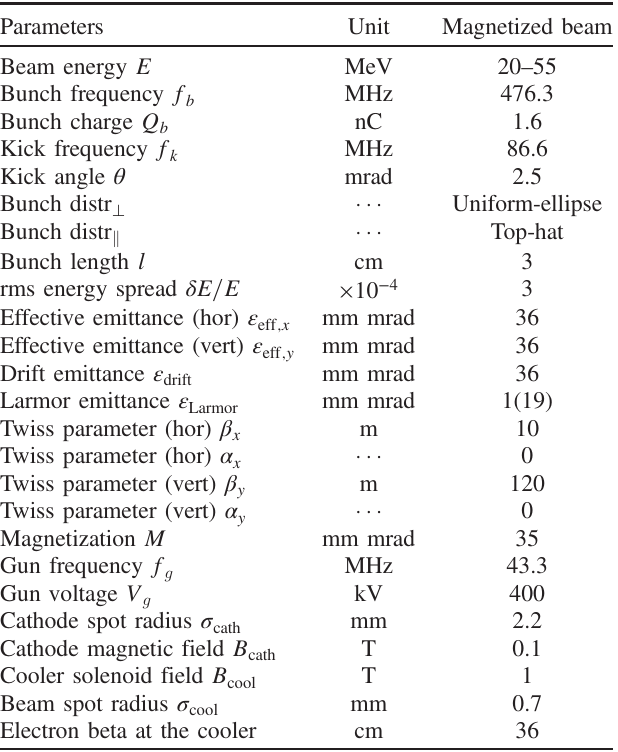
TABLE I. Beam parameters of the CCR at the kicker and at the photocathode gun. The Twiss parameters are at the kickers. The value in the bracket for the Lamor emittance refers to the tolerance limit.